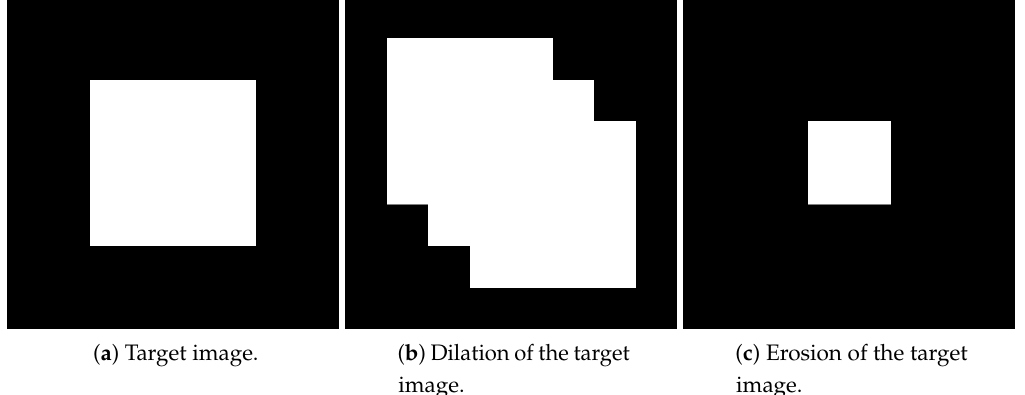
Figure 11. The target image and its dilation and erosion according to the structure element in Figure 7. ( a ) A simple example with 8 × 8 = 64 pixels and the central 4 × 4 = 16 pixels being white and the rest black. ( b ) The dilated image after applying the dilation operator to the original image. It’s actually the union set of the original image and two images after applying position shifting operator at opposite directions. ( c ) The eroded image after applying the dilation operator to the original image. It’s the intersection of the original image and two position shifted